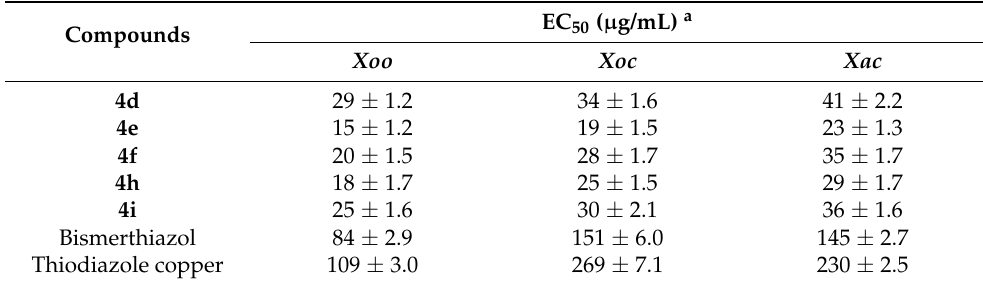
Table 2. The EC 50 values of some of the target compounds against Xoo , Xoc , and Xac .